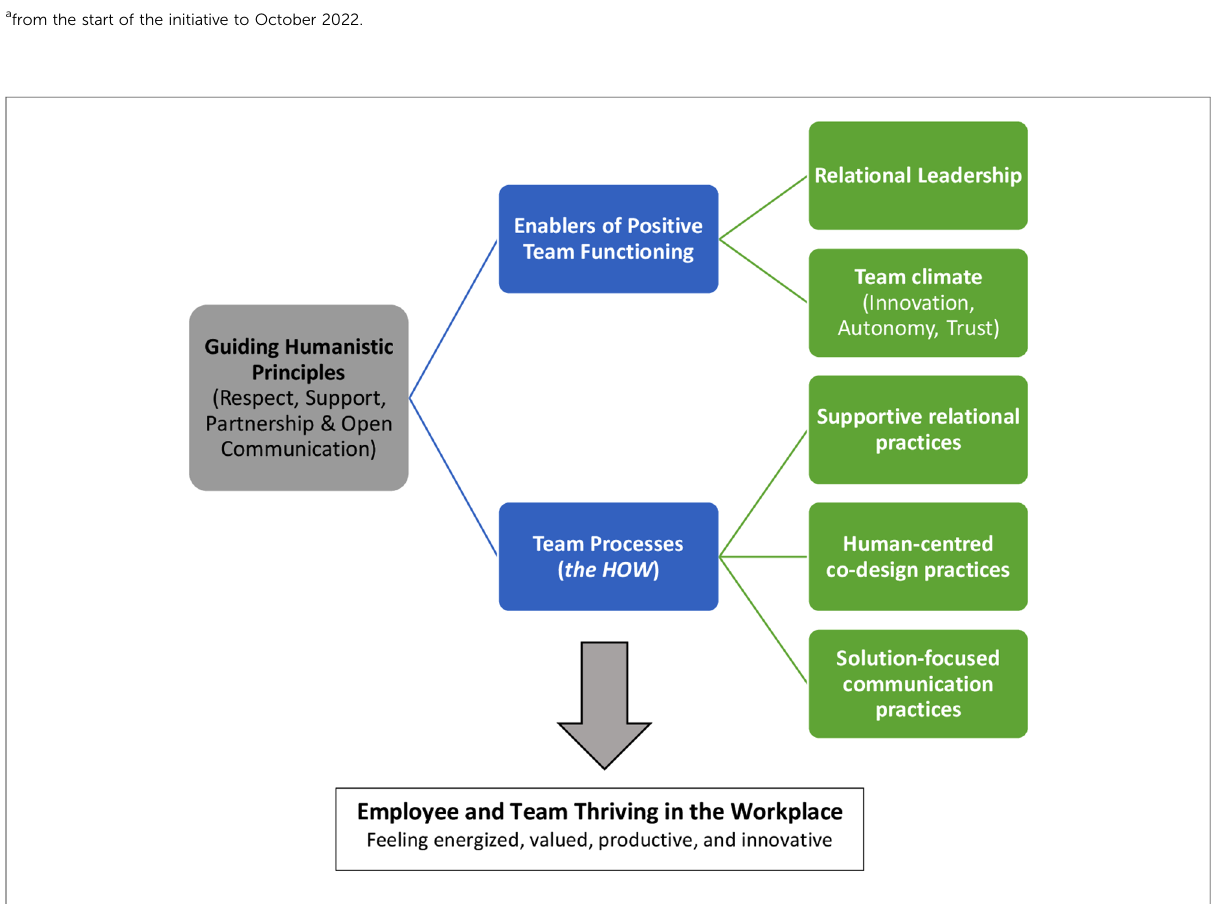
FIGURE 3 Guiding principles underlying team functioning and team practices in the Transition